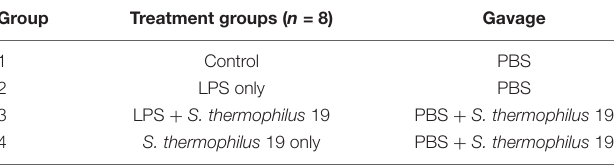
TABLE 1 | Experimental